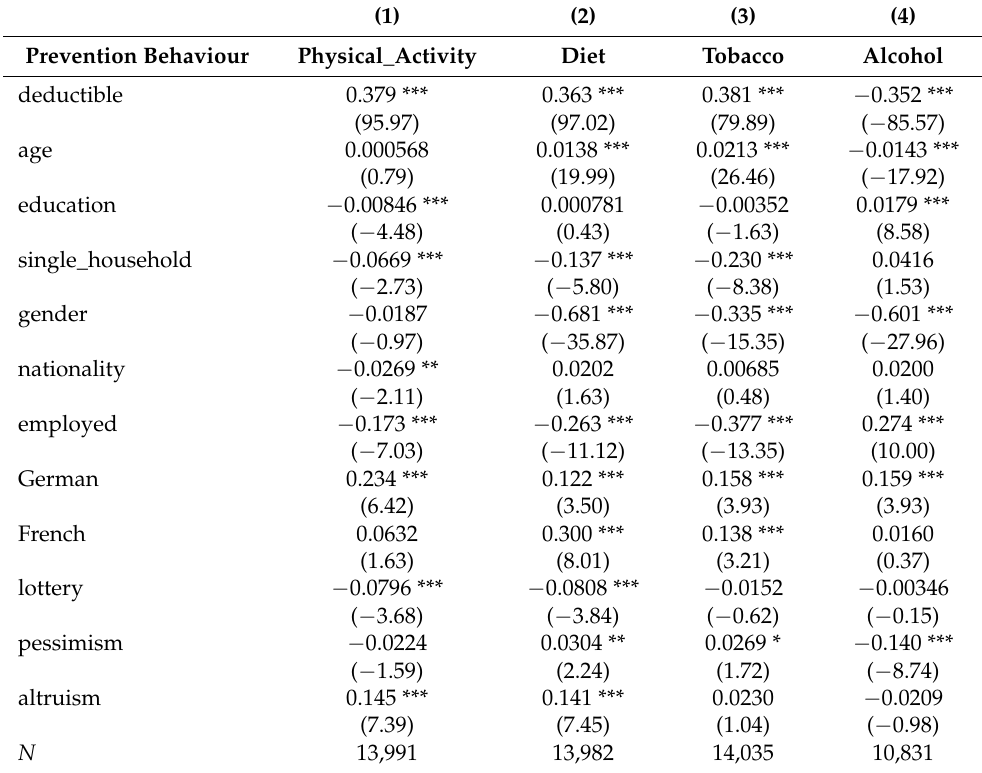
Table 7. Removing doctor